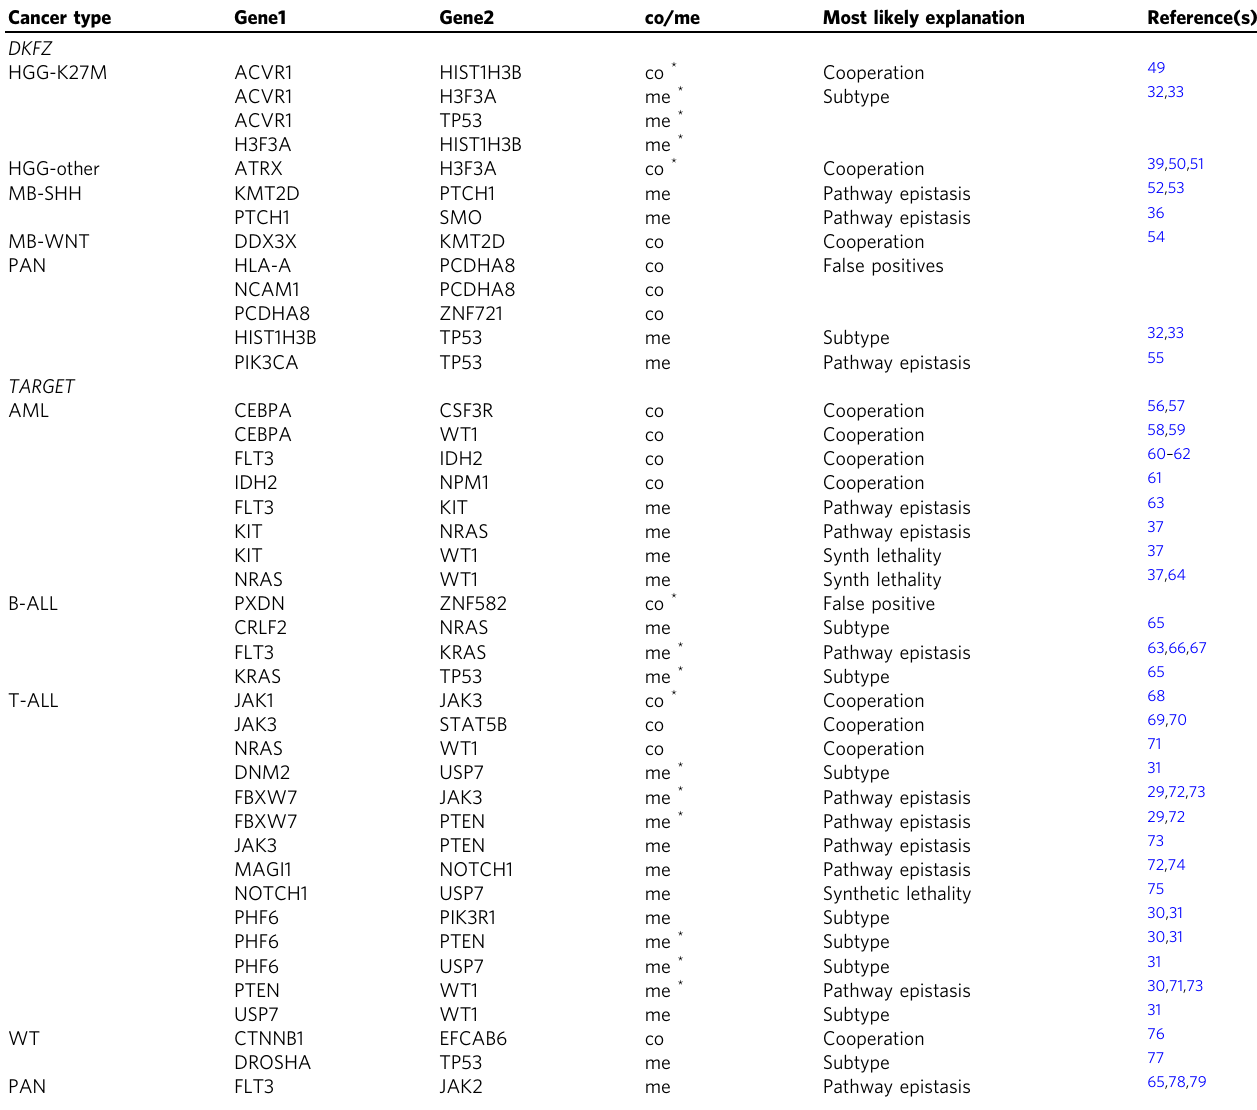
Table 2 Candidate genetic interactions and their underlying explanation. Cancer